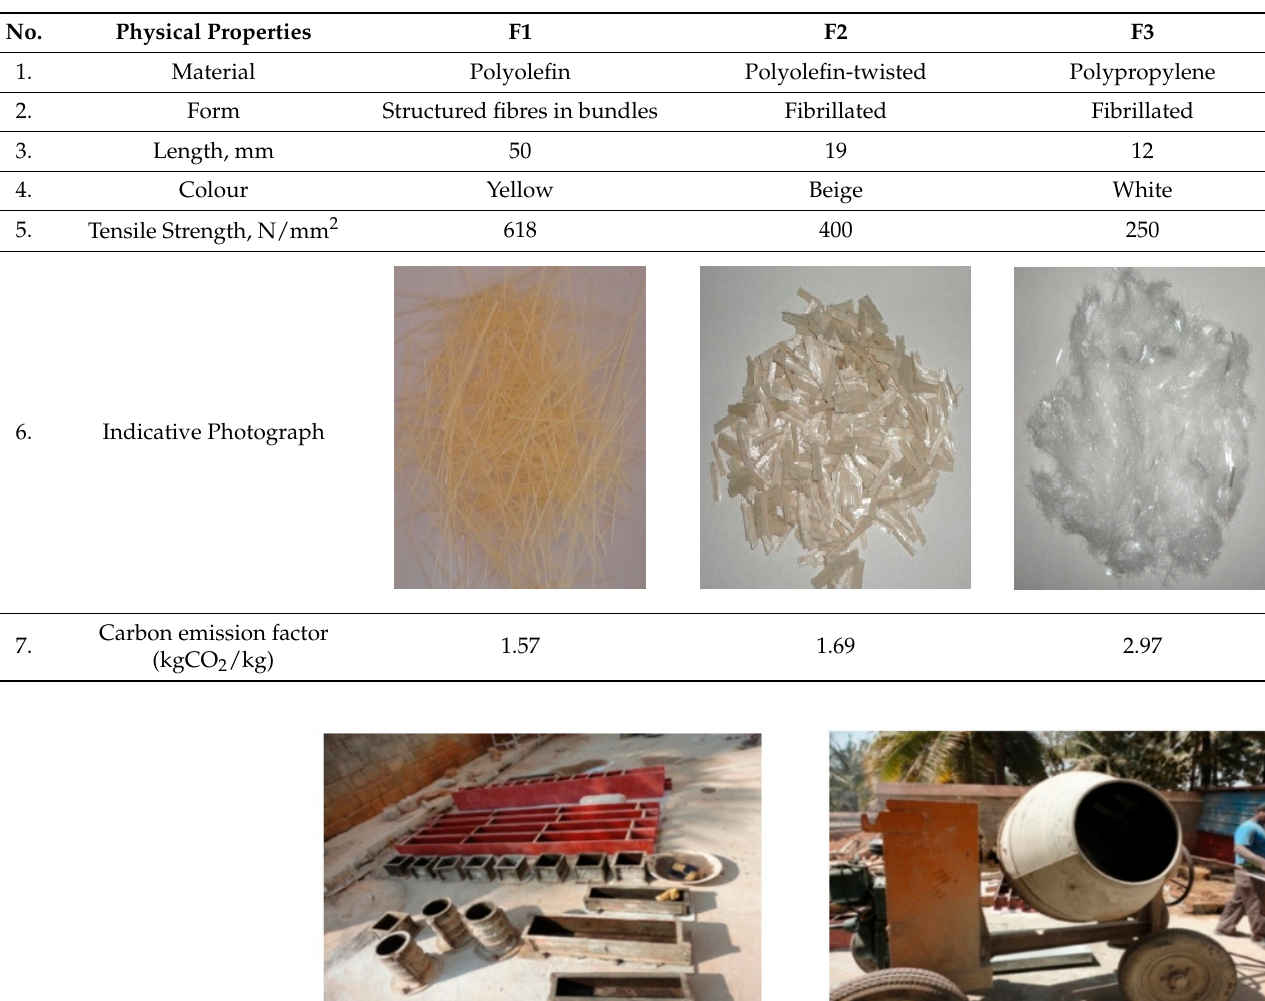
Table 1. Properties of fibres used for the study.